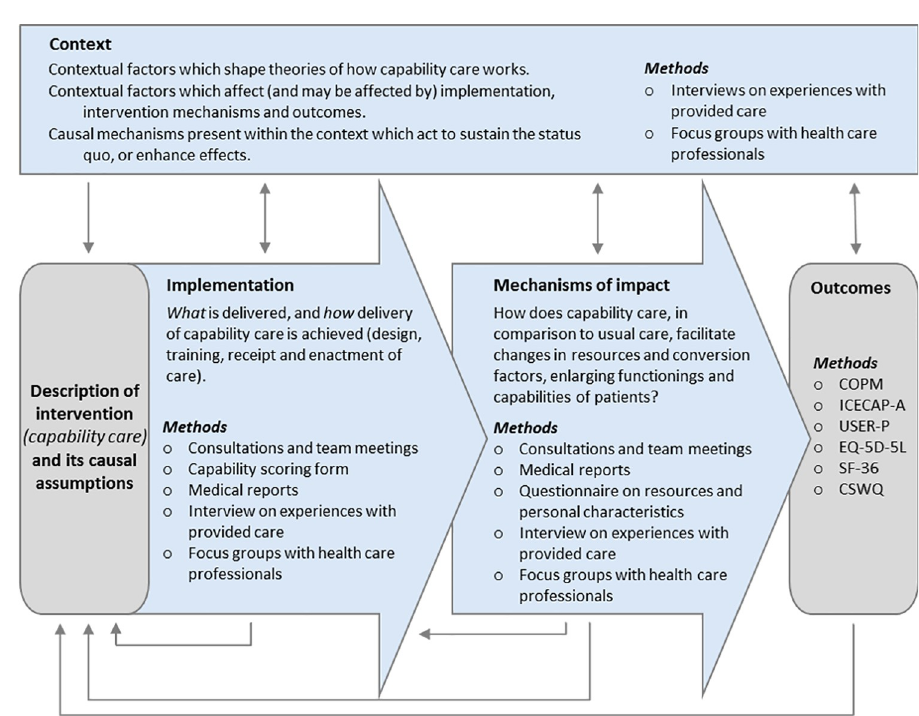
Fig 4. Process evaluation (adapted from Medical Research Council framework for process evaluation [13]). Blue boxes represent components of process evaluation, which are informed by the causal assumptions of the intervention, and inform the interpretation of (quantitative)